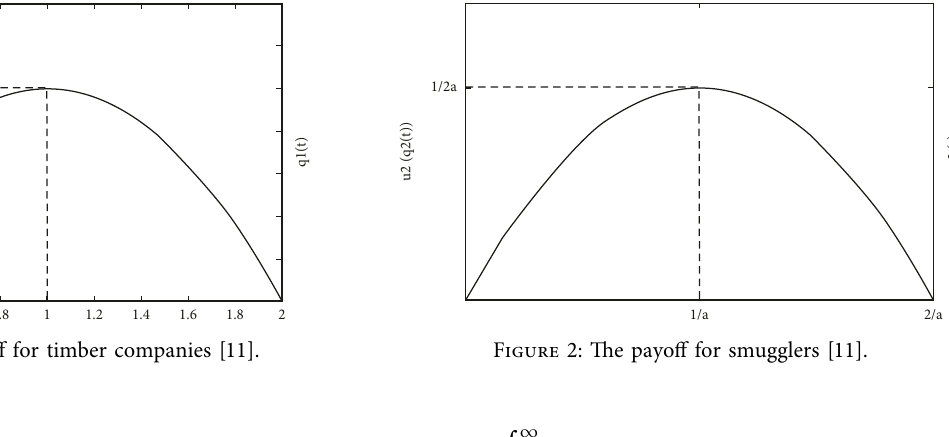
Figure 1: The payoff for timber companies [11]. Figure 2: The payoff for smugglers